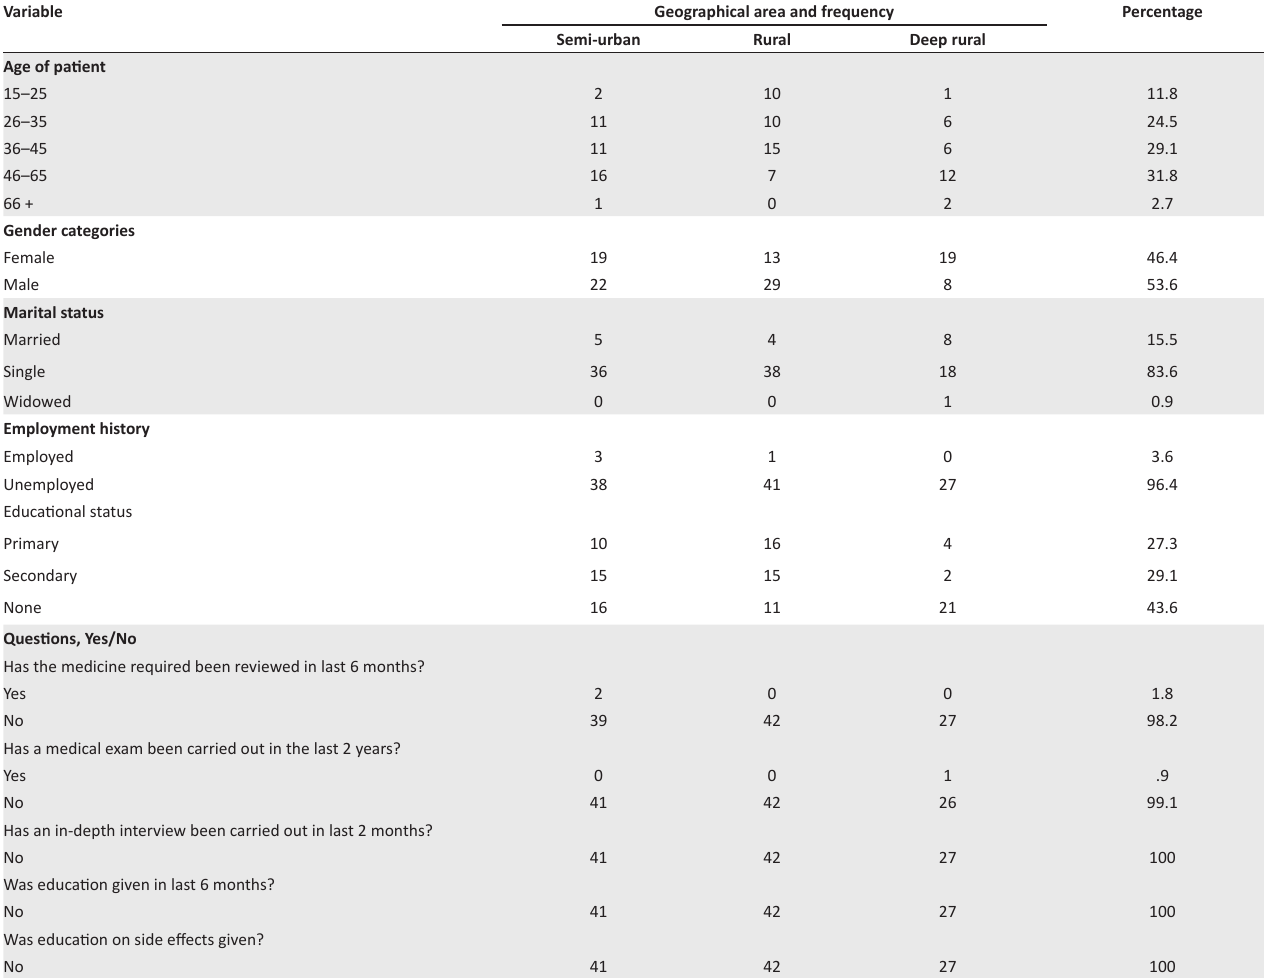
TABLE 5: Record review according to geographical area ( N = 110).